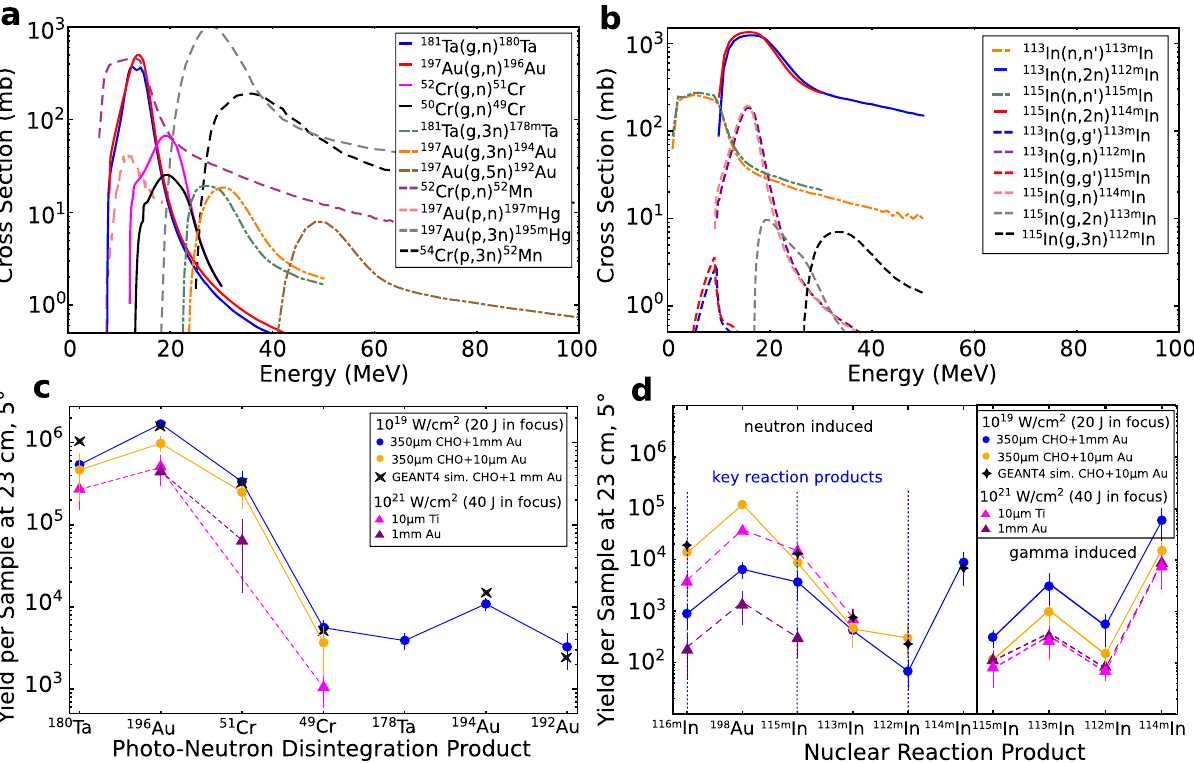
Fig. 8 Cross section. a and b present the nuclear reaction cross sections for the observed gamma, proton and neutron-induced reactions. c show the measured reaction yields together with simulated by means of GEANT4. The error bars represent the total error of the reaction yields, where the main uncertainty is caused by the geometrical detector ef fi ciency error and the error of the counting statistics. In panel d on the left, the pure neutron-induced reaction yields are shown for the laser-target setups (these numbers are obtained from the total measured yields after subtraction of yield of the corresponding gamma induced reactions leading to the same isotope). The key reaction products are used for neutron number